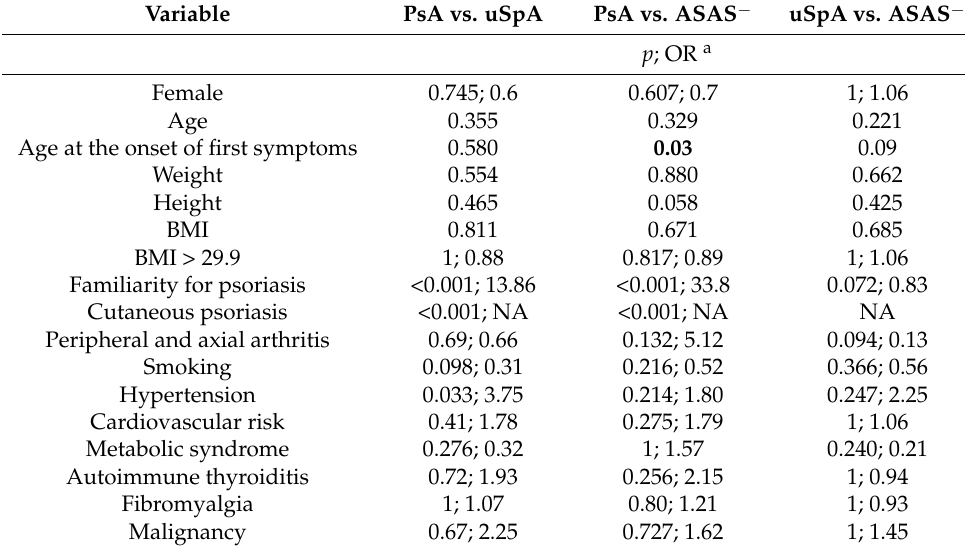
Table 3. HLA-B27 percentage in patients with peripheral seronegative enthesitis/arthritis (E/A) in the whole cohort (wE/A), in ASAS + psoriatic arthritis (PsA) and uSpA, and in ASAS − patients. Group ( n of Patients) B27 + ( n ; %) p a wE/A (113) 12; 10.61 0.001 PsA (54) 7; 13 0.001 uSpA (19) 5; 26.3 <0.001 ASAS − (40) 0; 0 1 Healthy donors (318) 7; 2.2